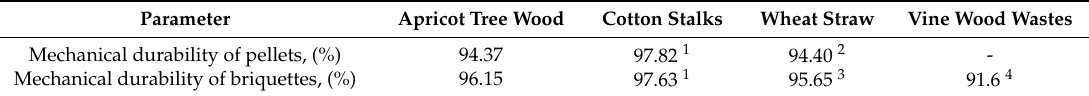
Table 4. The results of the mechanical durability for the tested briquettes and pellets made from apricot wastes in comparison with the durability of solid biofuel from other